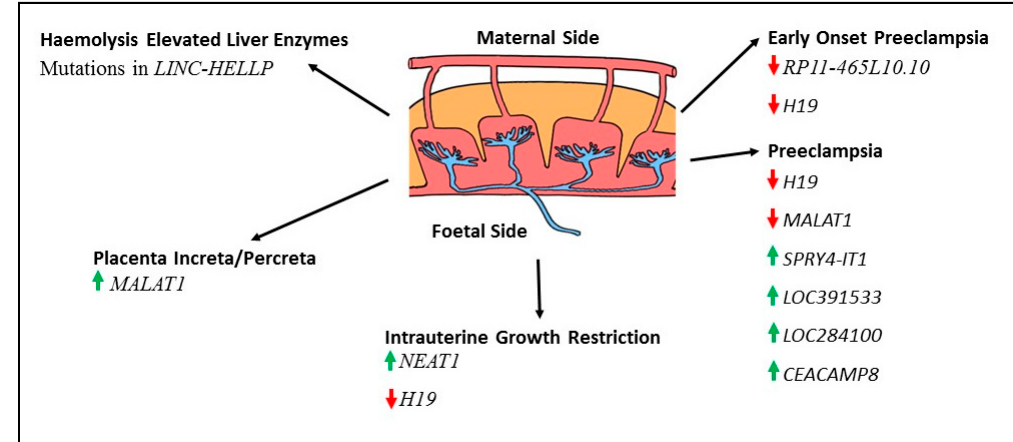
Figure 1. Summary of lncRNAs reported as altered in pregnancy complications. Green arrows indicate lncRNAs that are increased in pregnancy complications when compared to control samples and red arrows indicated those that are decreased in expression.